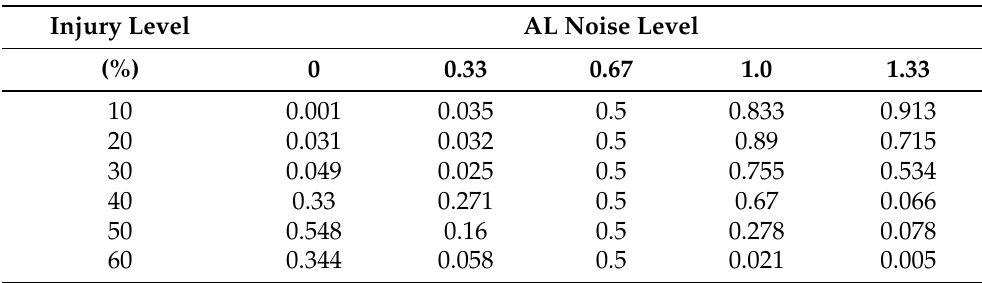
Table A4. P -values for normalized post-training effects of increased AL noise on average responses (see Figure 7D). p -values are markedly larger than for those corresponding to top-scoring responses (cf. Table A3), indicating weaker protective effects. p -values are for a given AL noise vs. AL noise = 0.67 (i.e., the middle value). N = 31 to 40 (mean = 35).